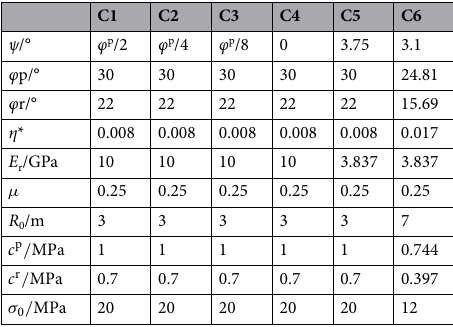
Table 9. Parameters of the tunnel cases for